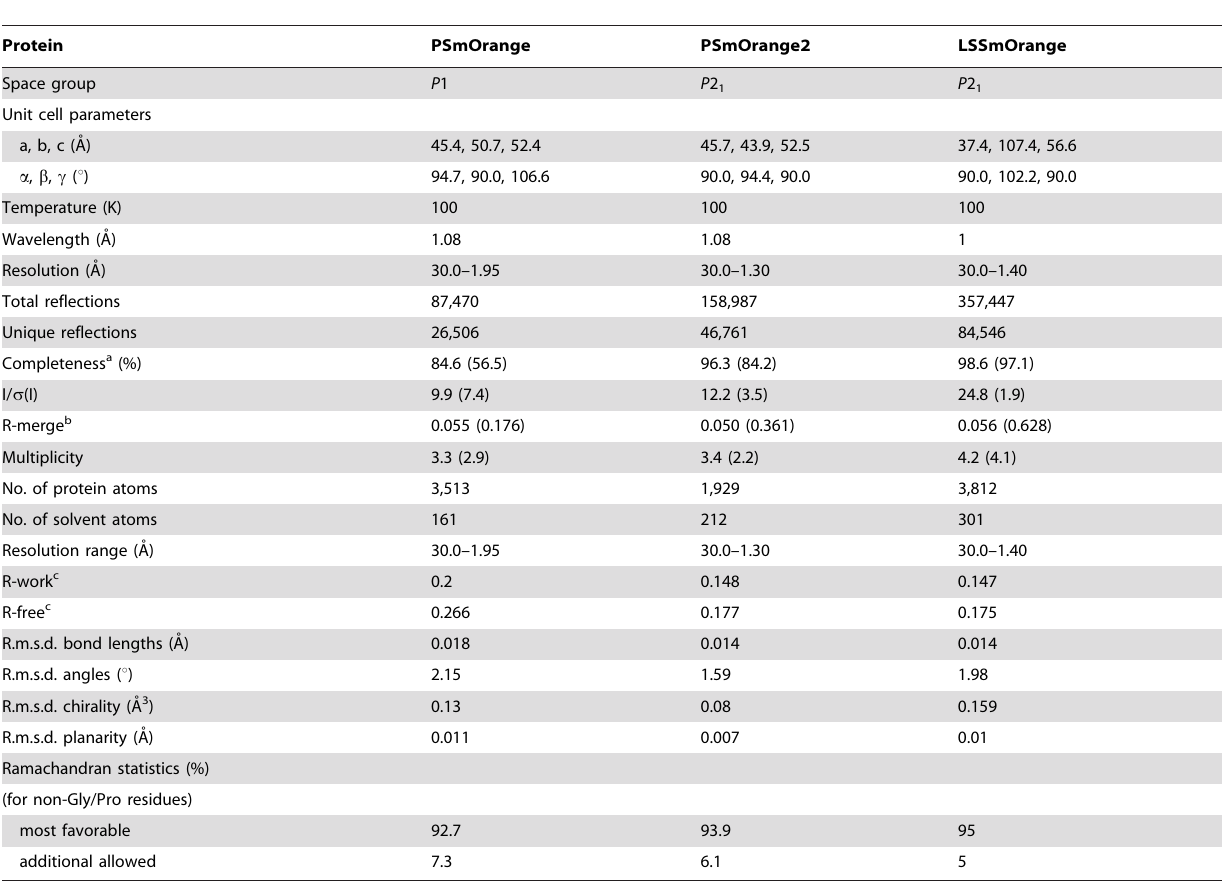
Table 2. Data collection and refinement